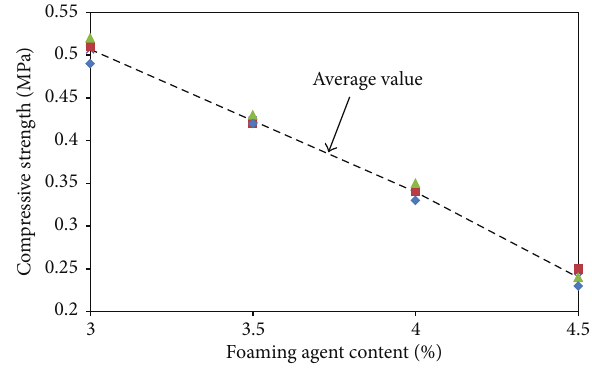
Figure 6: The influence of the FA content on the compressive strength of